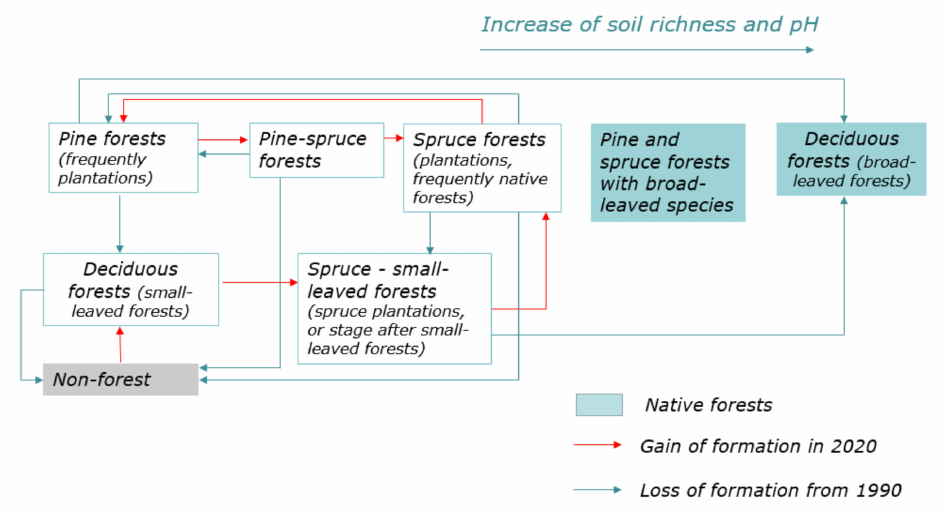
Figure 10. The RM of the coniferous